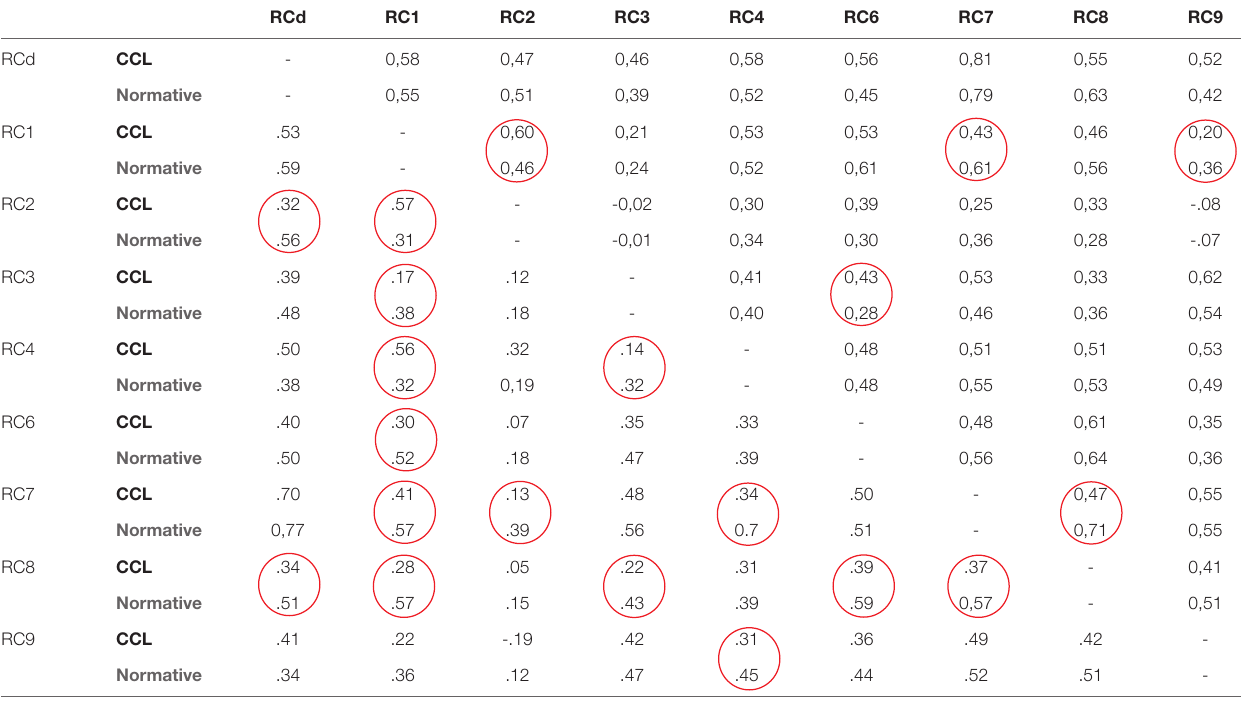
TABLE 2 | Raw score intercorrelation table for MMPI-2-RF RC scales presented separately by gender. RCd